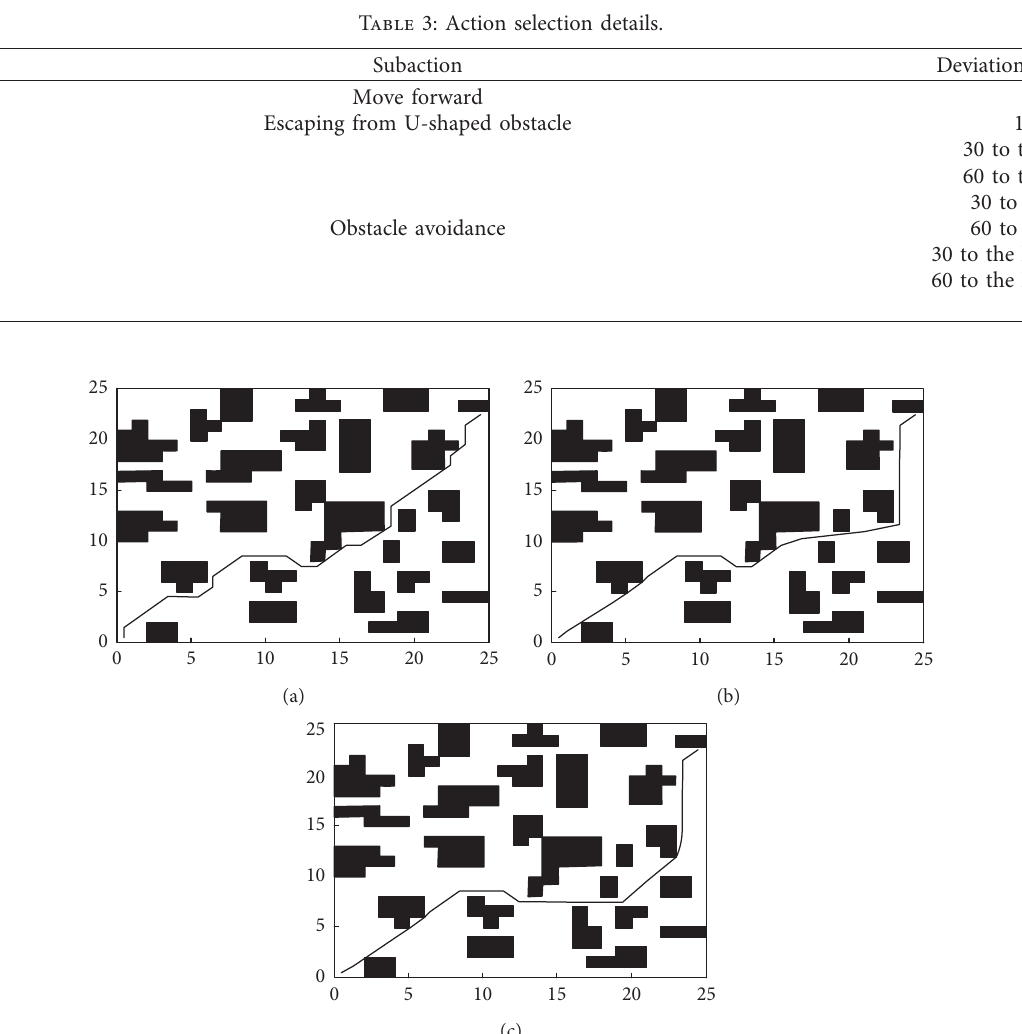
Figure 6: Path planning performance of different methods. (a) Path planned by the PSO algorithm. (b) Path planned by the GWO algorithm. (c) Path planned by the MGWO